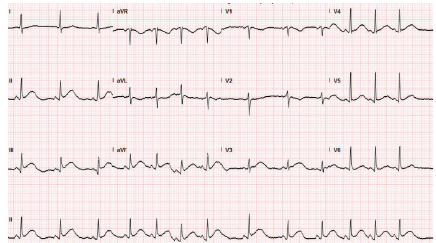
Figure 1: Admission EKG. ST segment elevations are noted in leads II, III, and